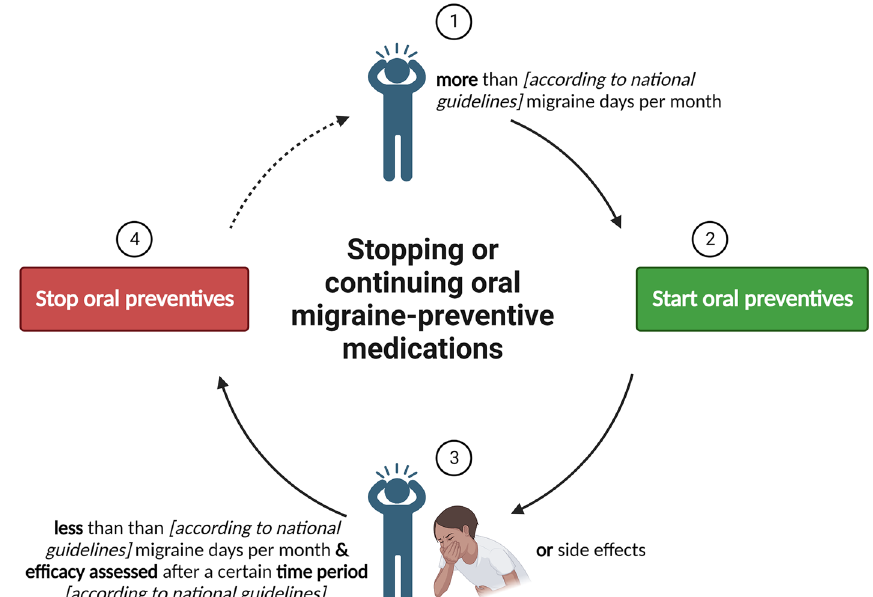
Fig. 2 An illustrative tool for stopping or continuing oral migraine preventive